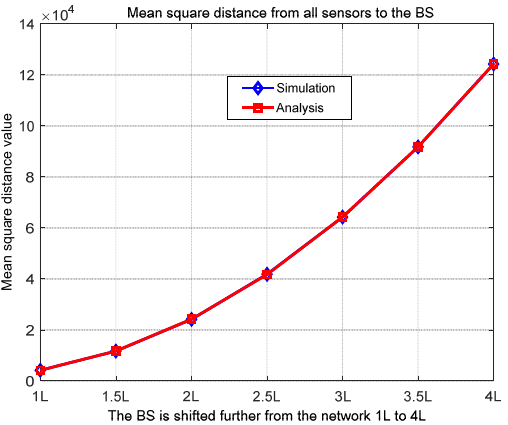
Figure 4. Average square distance ( E [ d 2 random walks and the BS at different positions L